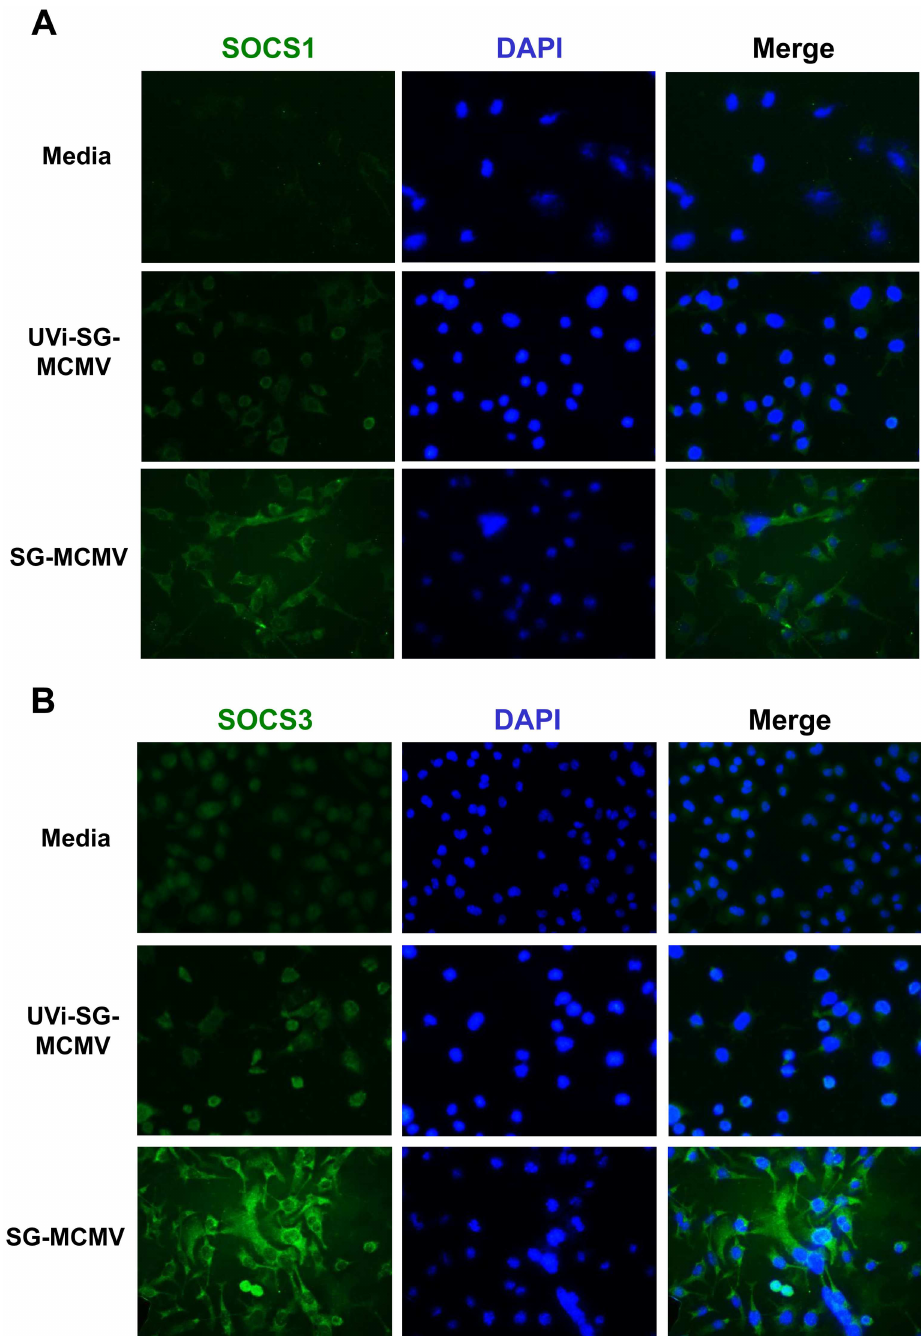
Fig 4. UV-inactivation of MCMV reduces MCMV-related stimulation of SOCS1 and SOCS3 protein in mouse macrophages. IC-21 mouse macrophages grown on glass cover slides were treated with media (control), infected with SG-MCMV (MOI = 3 PFU/cell), or treated with an equal volume of UVi-MCMV. All groupswere fixed at 3 hpi and assessed by immunofluorescent staining for SOCS1 (A) or SOCS3 protein (B) (green), counterstained with DAPI (blue). Originalmagnification,